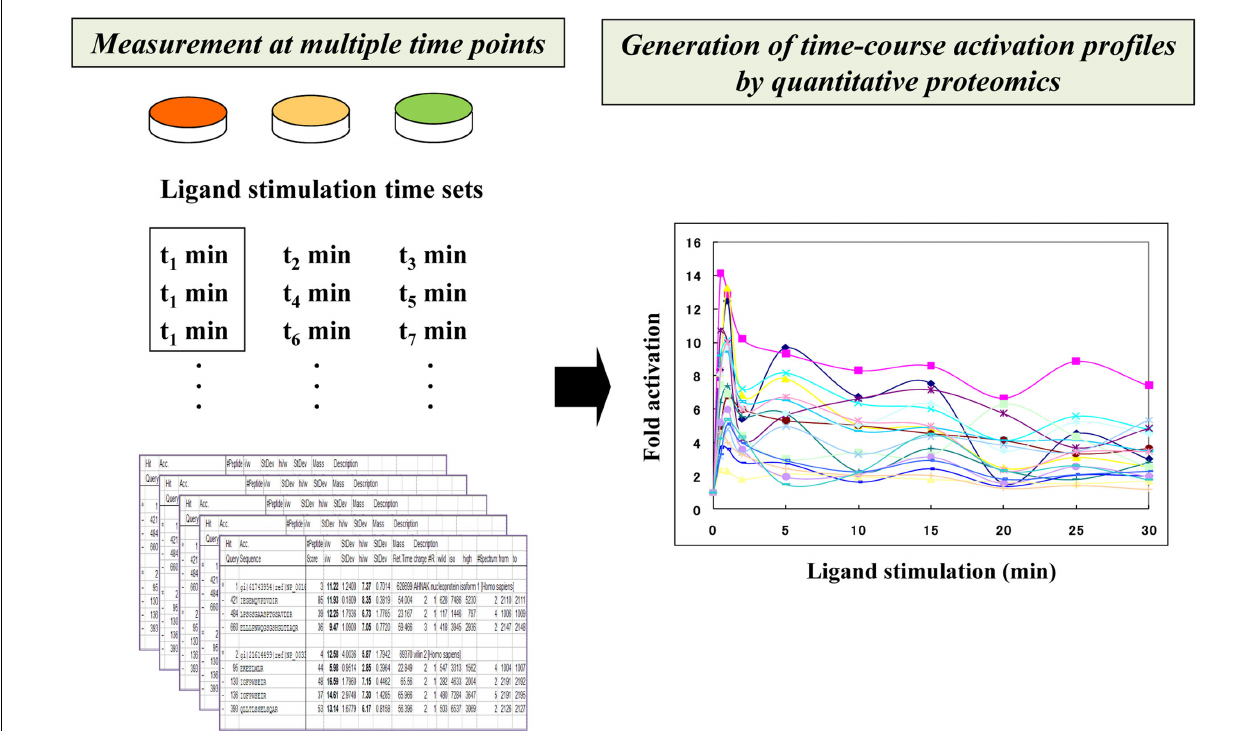
FIGURE 2 |Time-resolved description of signaling networks by quantitative proteomics. Time-course activation profiles of phosphorylated molecules are generated through integration of a series of fold activation data that were measured at different time